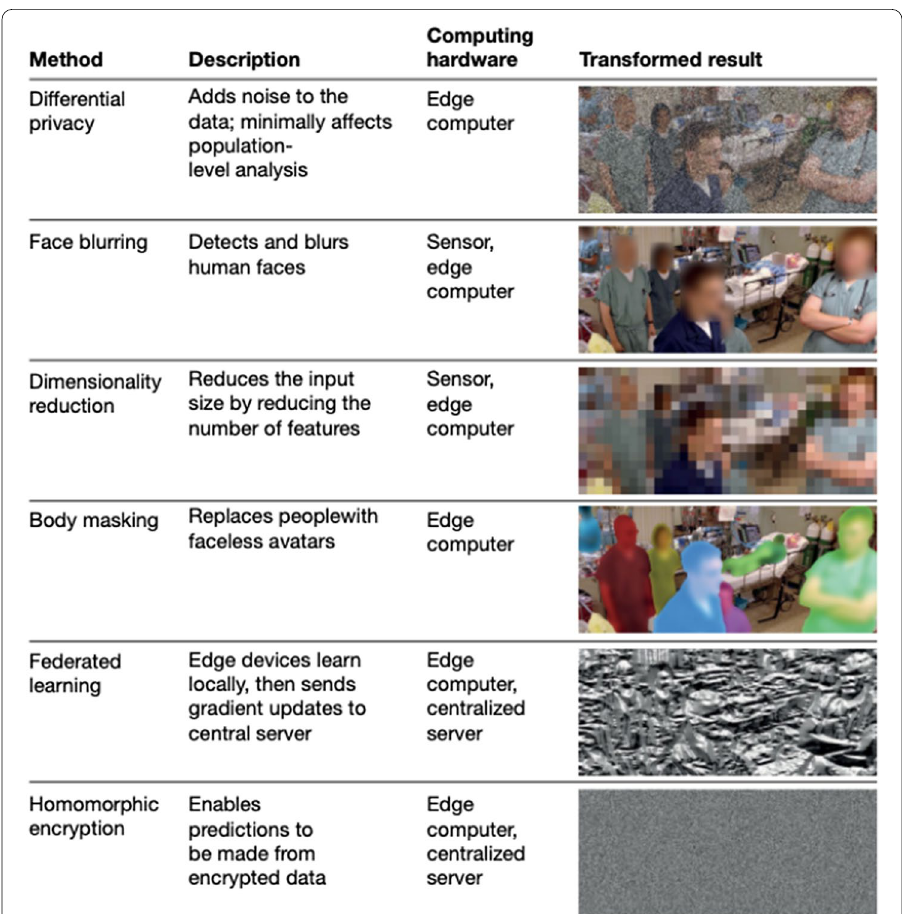
Fig. 22 Privacy-preserving techniques explored in applications of Ambient Intelligence (Image taken from Haque et al.